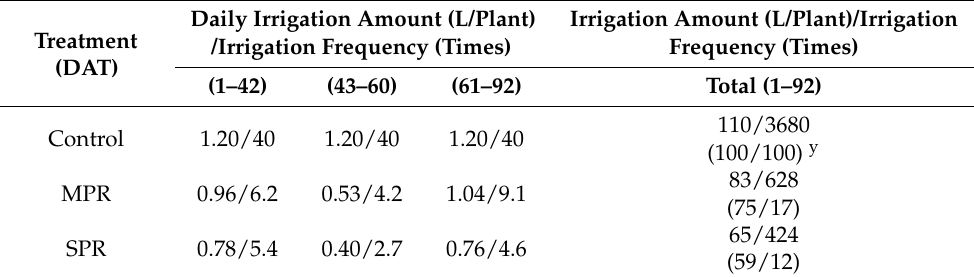
Table 2. Irrigation amount and frequency during a 92-day experimental period.